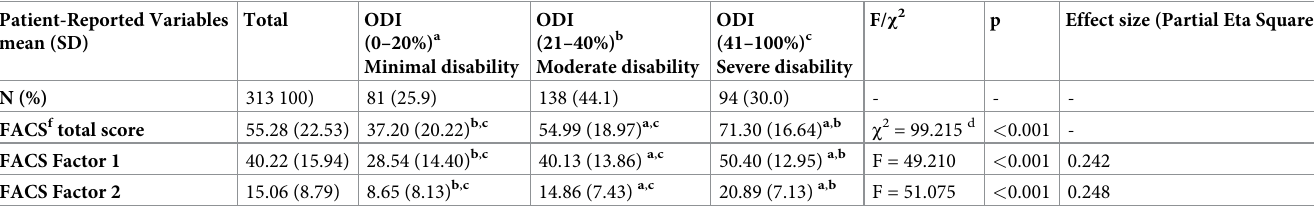
Table 3. FACS-Serb total scores and subscale factor scores by ODI severity groups. Patient-Reported Variables mean